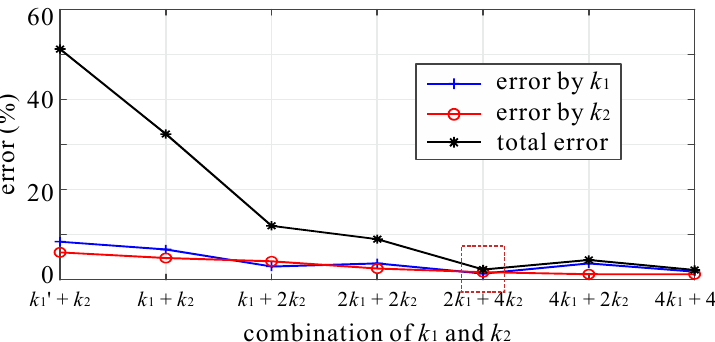
Figure 12. Induced errors regarding different stiffness.